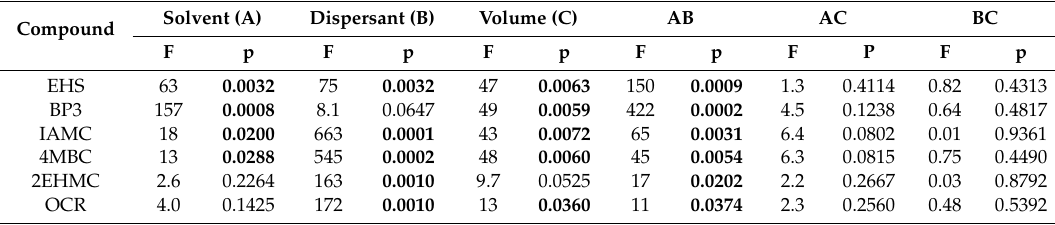
Table 3. ANOVA summary table obtained for the micro-matrix solid-phase dispersion ( µ -MSPD)